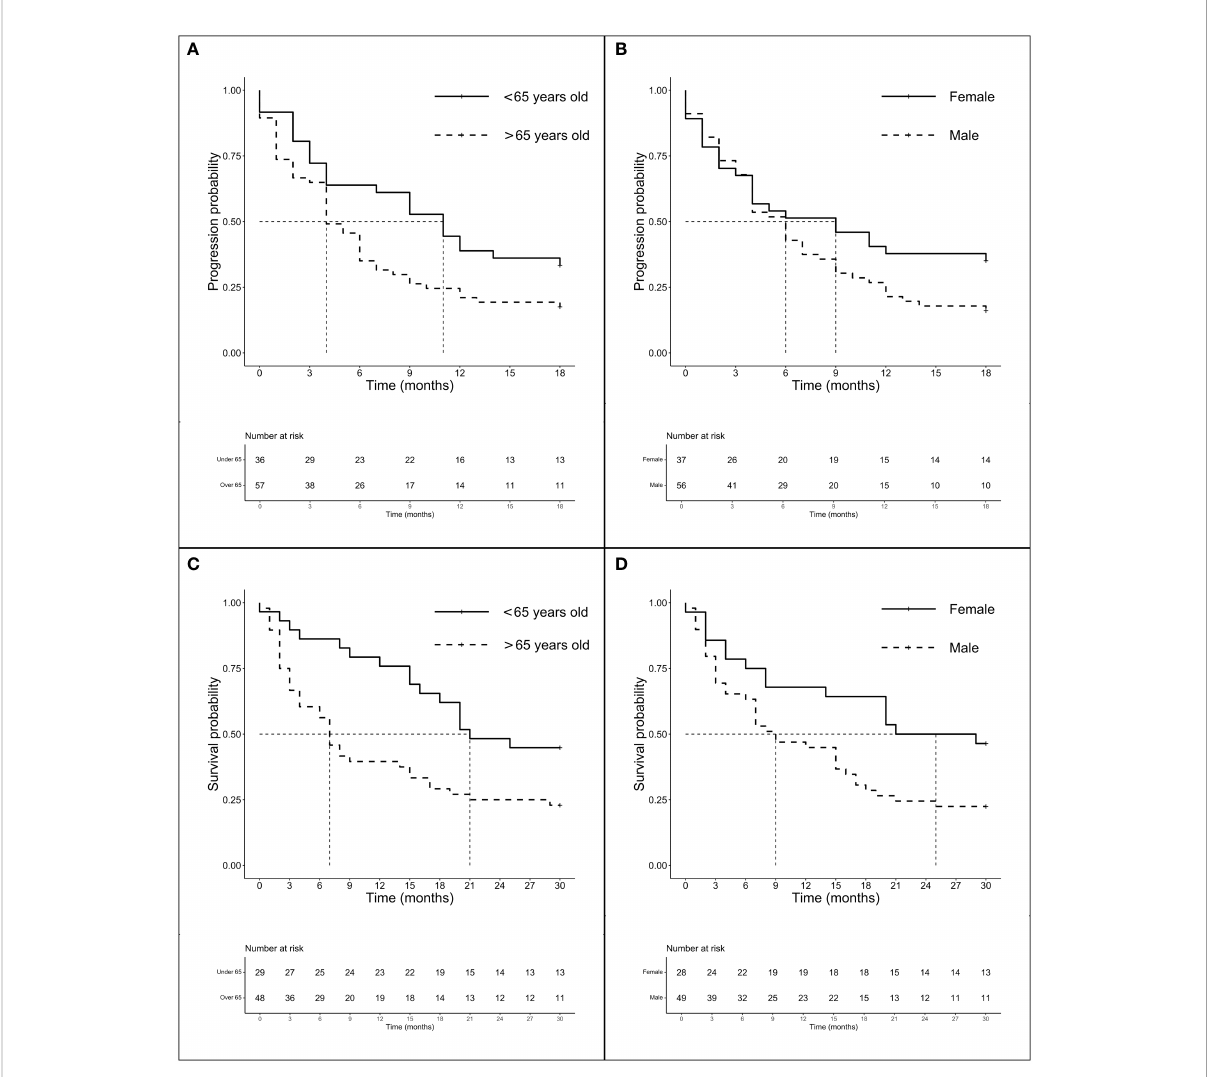
FIGURE 2 Survival analysis (PFS and OS) according to age and gender. Survival analysis (PFS and OS) of G12 patients according to age (panels A and C) and gender (panel B and D). (A) mPFS of patients < 65 years ( n = 62) vs . patients > 65 years ( n = 119): 6.0 months (95% CI 4.0 – 11.0 months) vs . 4.0 months (95% CI 4.0 – 6.0 months), p = 0.518. (B) mPFS of female ( n = 71) vs . male ( n = 110): 6.0 months (95% CI 4.0 – 11.0 months) vs . 4.0 months (95% CI 3.0 – 6.0 months), p = 0.013. (C) mOS of patients < 65years ( n = 56) vs . patients > 65 years ( n = 109): 20.5 months (95% CI 10.0 – NR months) vs . 13.0 months (95% CI 9.0 – 17.0 months), p = 0.007. (D) mOS of female ( n = 63) vs . male ( n = 102): 23.0 months (95% CI 18.0 – NR months) vs . 14.5 months (95% CI 9.0 – 17.0 months), p =